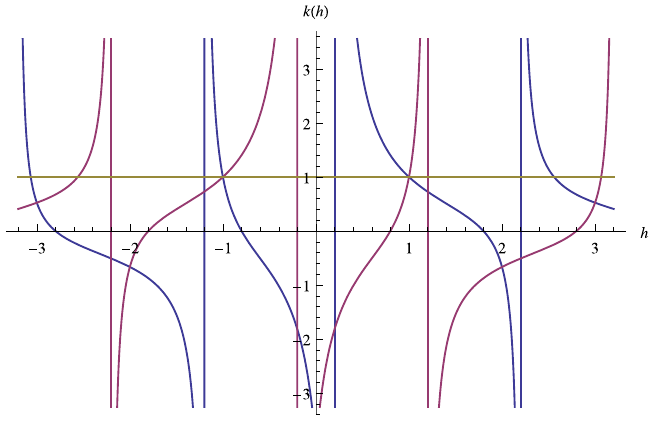
Figure 3 . Eigenvalues of the antisymmetric (red) and symmetric (blue) kernels at ˆ q =